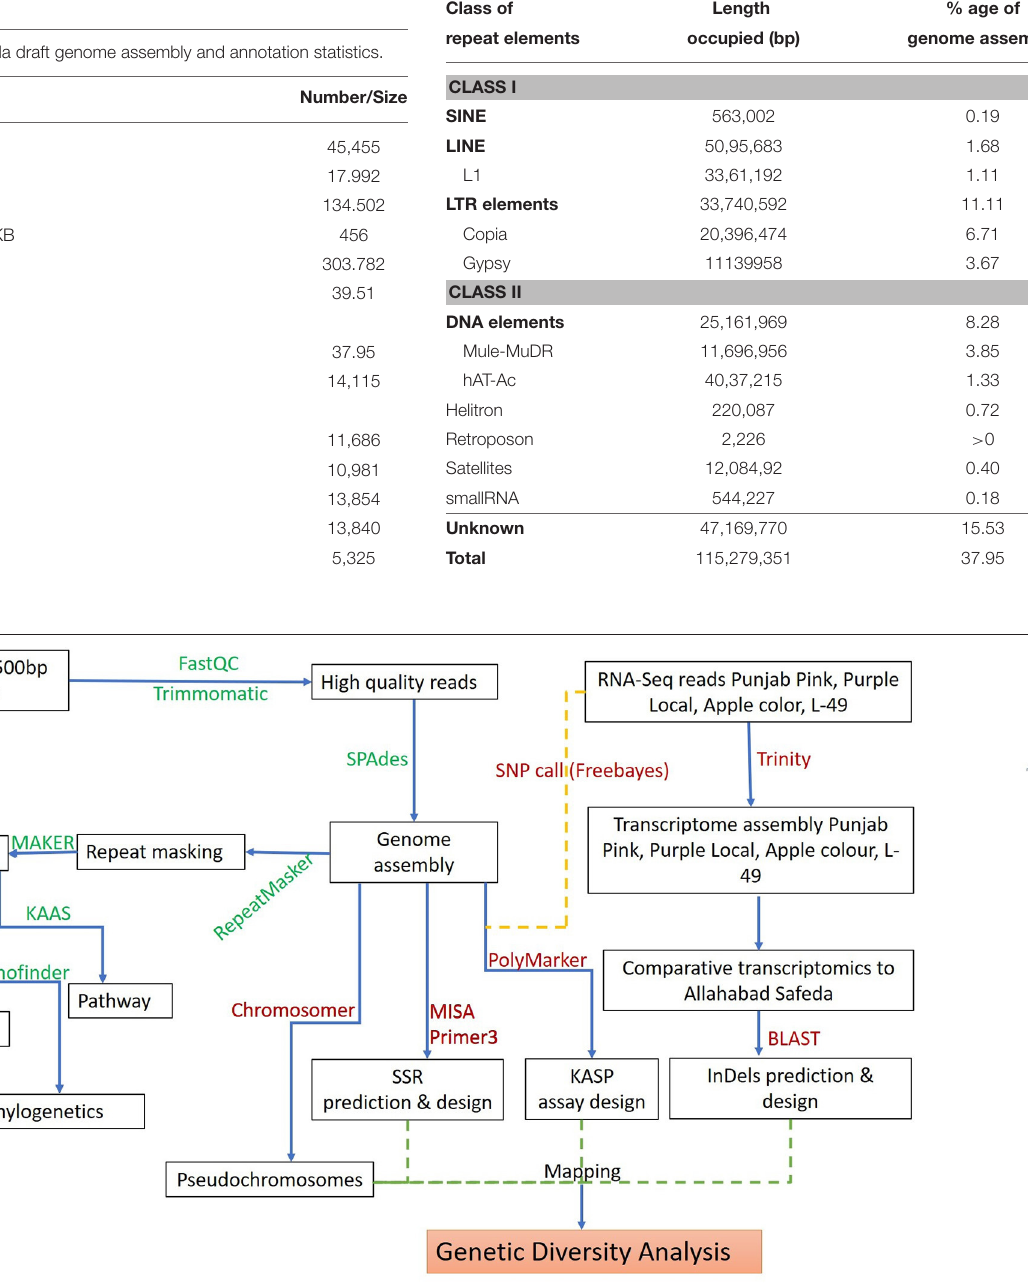
TABLE 3 | Allahabad Safeda draft genome assembly repeat analysis.